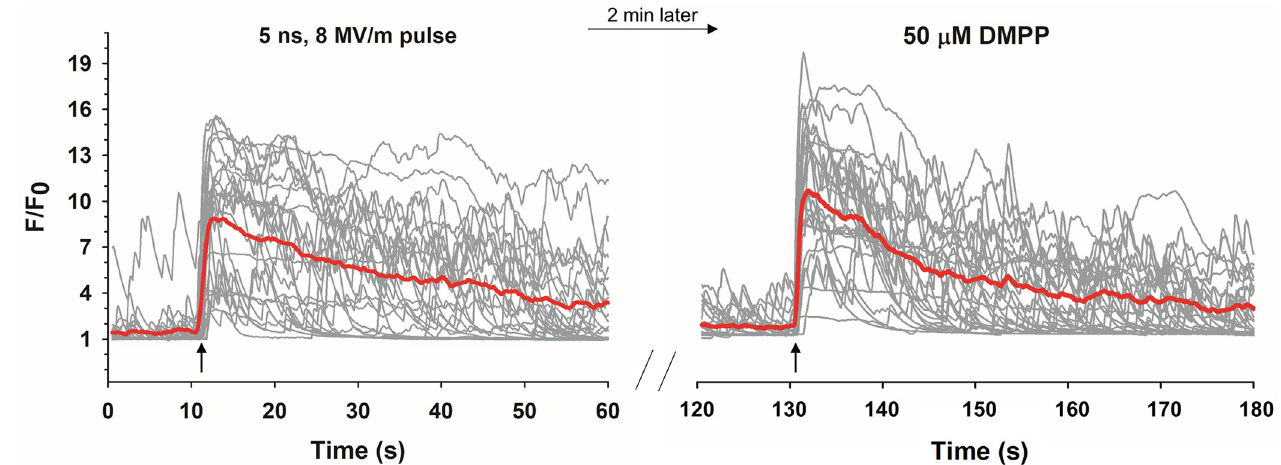
Fig 10. nAChR-evoked Ca 2+ responses after NEP exposure. Representative fluorescence traces together with the averaged responses (red line) showing the Ca 2+ response in mouse GCaMP6f-expressing ACC to a 5 ns pulse and the response of the same cells to DMPP 2 min later ( n = 3, c = 26). The arrow indicates when the stimulus was